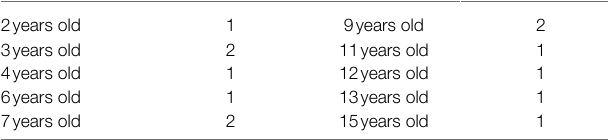
TABLE 2 | Age at 1 st separation. TABLE 3 | Age at the time of their exile to mainland